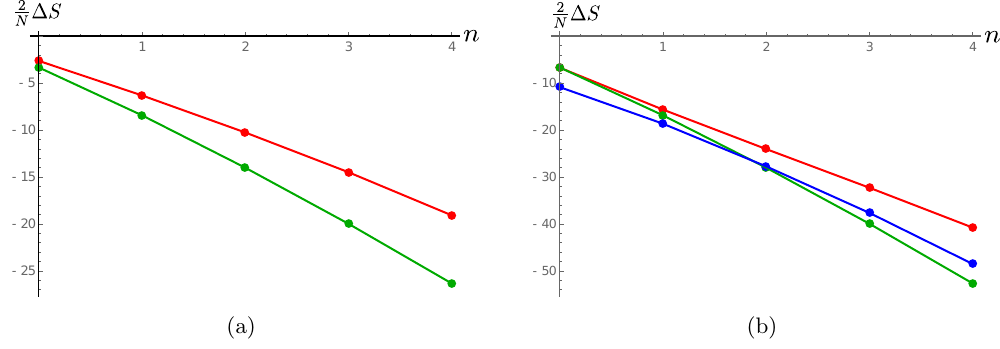
Figure 4 . On-shell action on the solutions as a function of n , which labels the Matsubara frequency pair, for which in the initial q = 2 solution the G (1) was replaced by either G (2) (green), G (3) (red), or G (4) (blue). (a) M = 2. The solutions corresponding to G (3) and G (4) in this case have equal values of the action (shown by the red curve). (b) M = 4. Here (cid:12)J = 20 (cid:25)